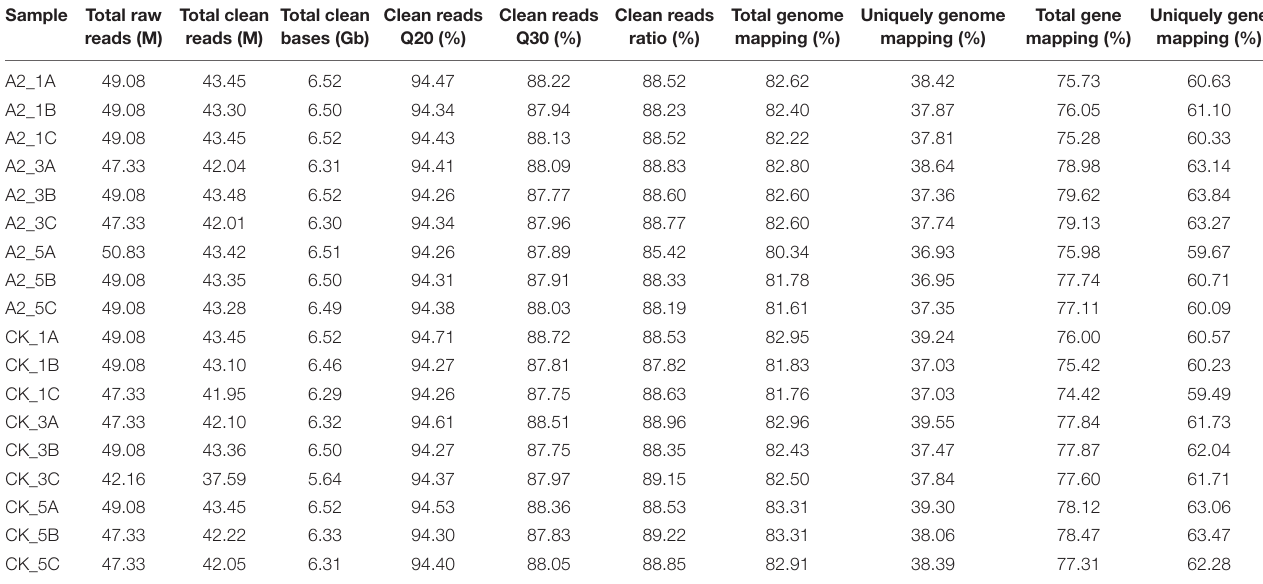
Table 5 ): Cellular process (2,122), metabolic process (1,842), and biological regulation (673) were represented as major Table 6 ). Significantly enriched KEGG pathways in